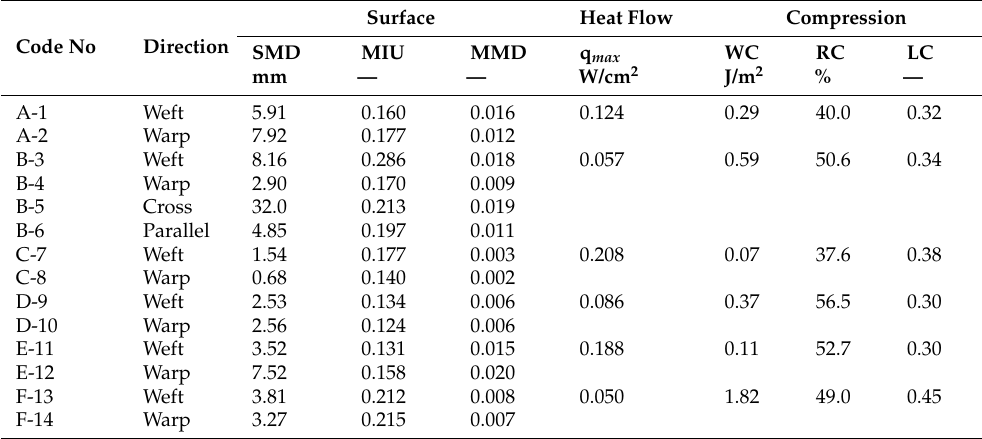
Table 2. Sample physical